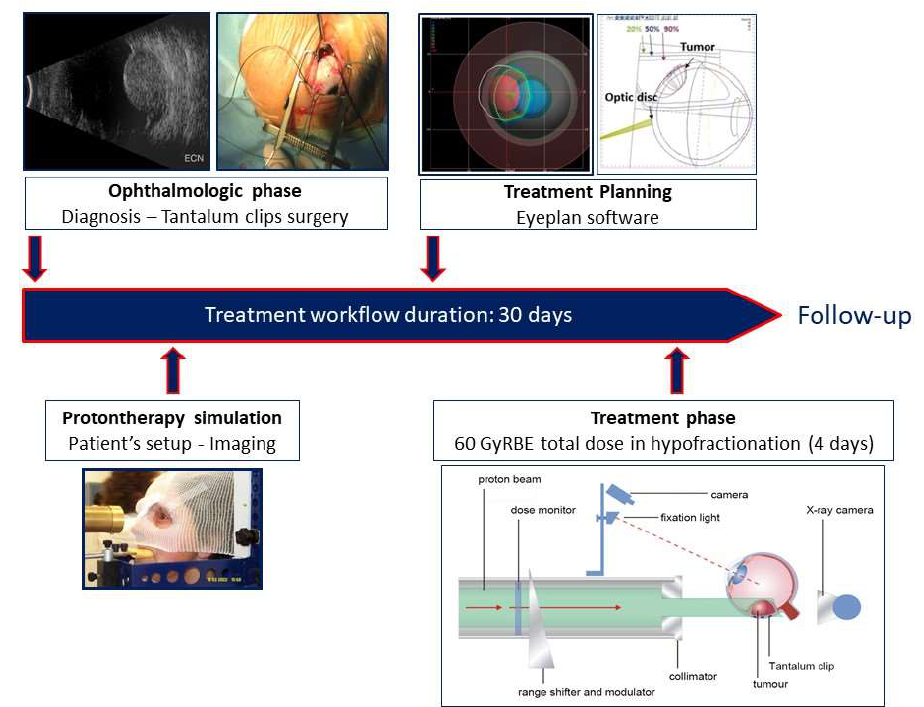
Figure 1. Proton beam radiotherapy workflow.